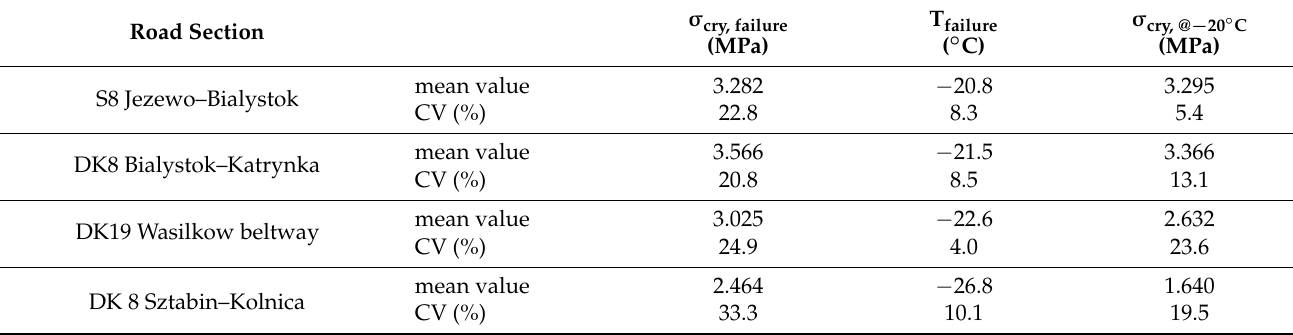
Table 5. Test results of TSRST for the base